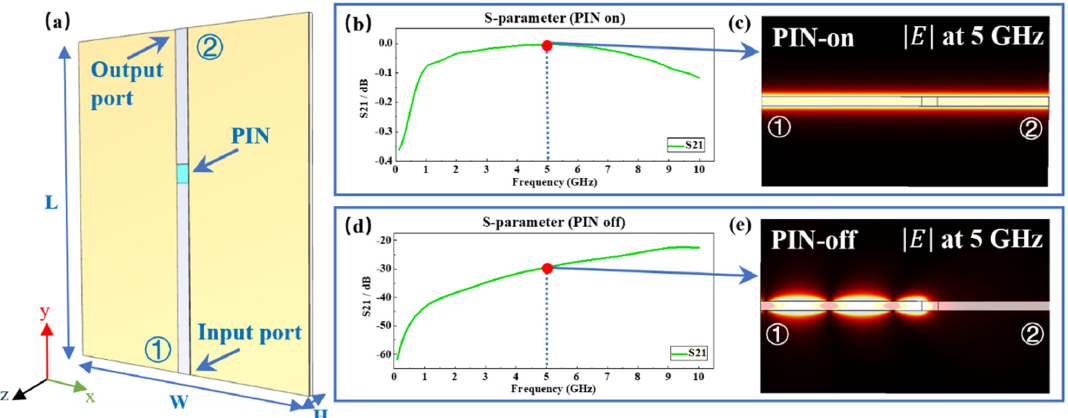
Figure 2. Microstrip in the static case: ( a ) Schematic of a microstrip composed of a PIN diode; ( b ) Transmission coefficient (S21) when the PIN diode is switched on; ( c ) Near-field distribution at 5 GHz when the PIN diode is switched on; ( d ) Transmission coefficient (S21) when the PIN diode is switched off; ( e ) Near-field distribution at 5 GHz when the PIN diode is switched off.